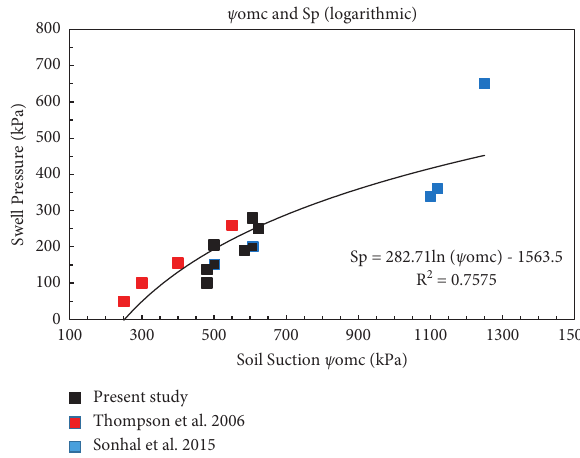
Figure 7: Presentation of suction-based logarithmic correlation for swell